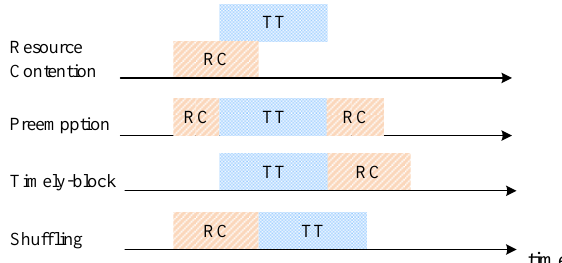
Figure 2. Integration policies of time-triggered (TT) and rate-constrained (RC)